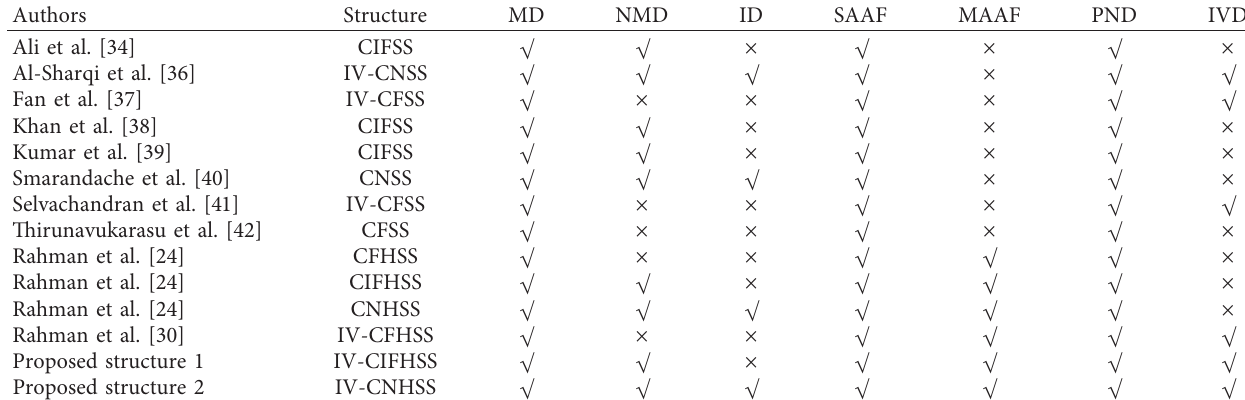
Table 9: Comparison with existing models under appropriate